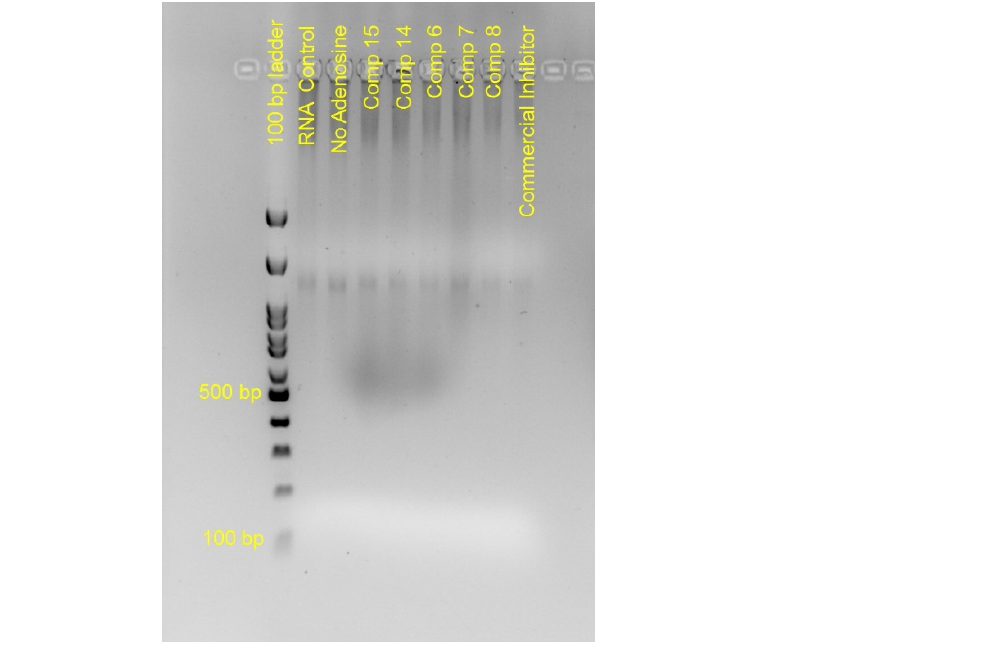
Figure 9. In-vitro assay using NSP12 polymerase and different adenine, guanine and cytosine nu- cleoside